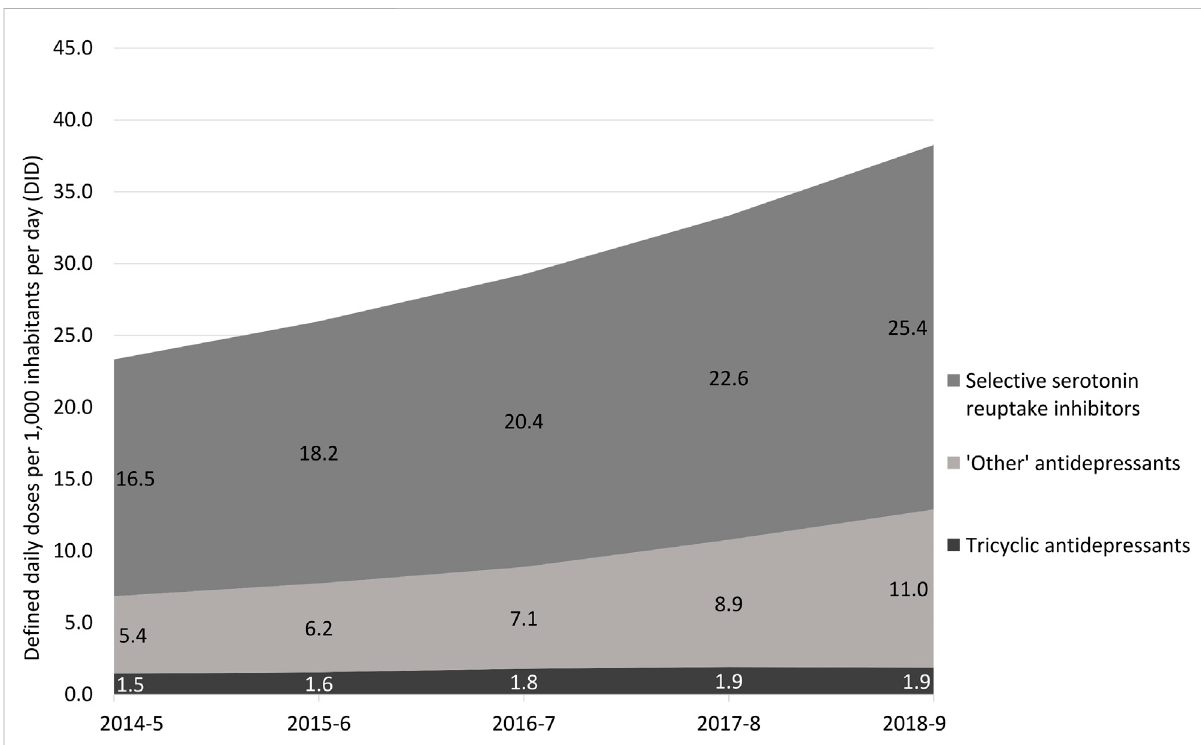
FIGURE 2 Sales of antidepressants in Brazil from November 2014 to October 2019 in de fi ned daily doses per 1,000 inhabitants per day (DID) according to the main pharmacologic categories. Note: monoamine oxidase inhibitors were excluded of this analysis due to low DID ( <